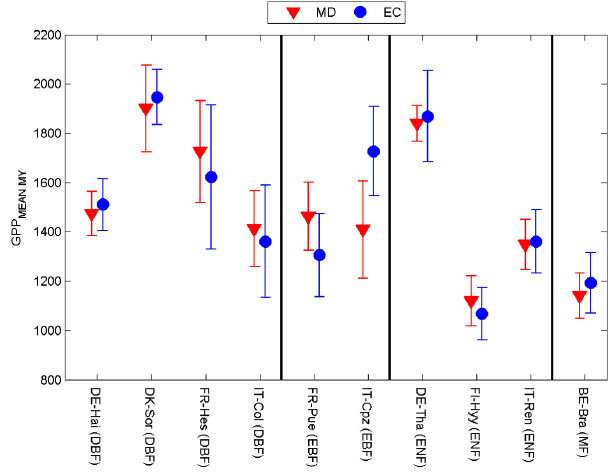
Figure 3. Distributions of annual GPP (gCm − 2 year − 1 ) . MD (red) are model results, EC (blue) measured by eddy covariance. The ver- tical bars represent ± 1 standard deviation. DE-Tha refers to the 1S simulation, IT-Ren to the 2L_2C simulation, BE-Bra to the P_Q-3L simulation (see